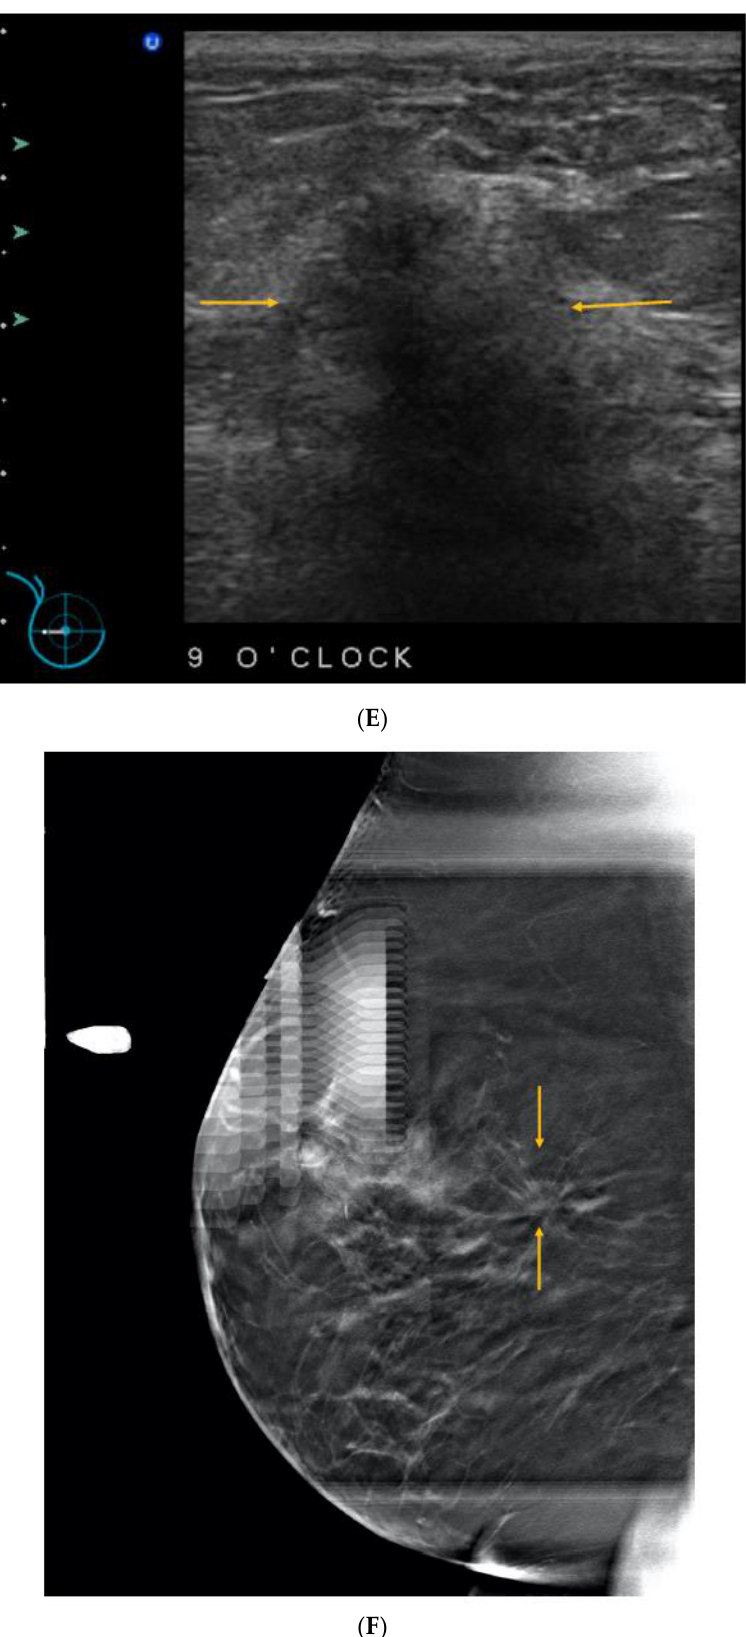
Figure 5. Fifty-eight-year-old woman with 2 cancers: one seen on DBT but not visible with US, and one seen on US but not on DBT. She presented for screening with DBT. ( A ) Right 2D MLO view was